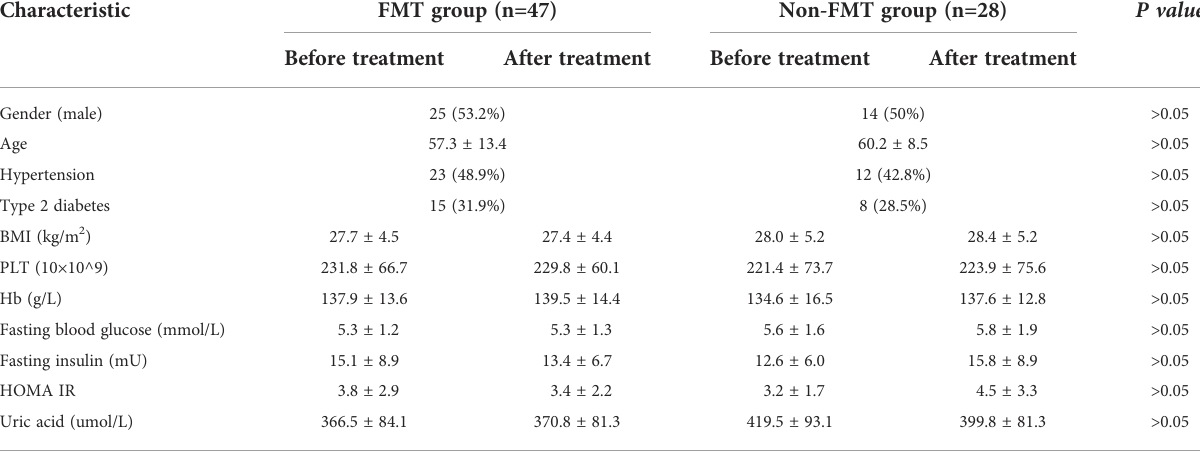
TABLE 1 Baseline comparison between FMT group and non-FMT group.